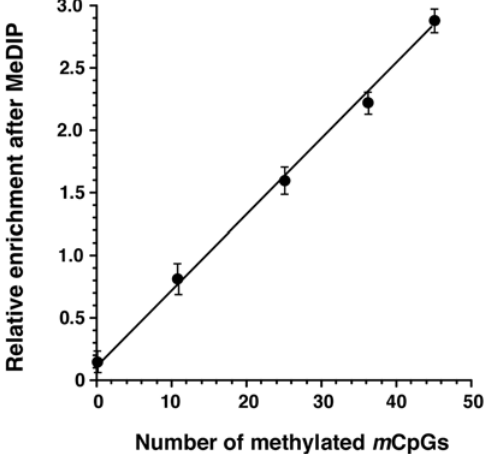
Figure 3. Relationship between the pixel density of MeDIP- generated signals and the number of methylated CpGs present in test DNA fragments of similar size (449, 446, 440, 445, and 449 bp) but containing different numbers of methylated CpGs (0, 11, 25, 36, or 45, respectively). Each data point represents the mean 6 SEM values for 3 clones. The linear regression line was fitted using GraphPad Prism software. Note the linearity of the plotted relationship, indicating that the MeDIP assay can quantitatively detect the number of methylated CpGs within a DNA fragment.